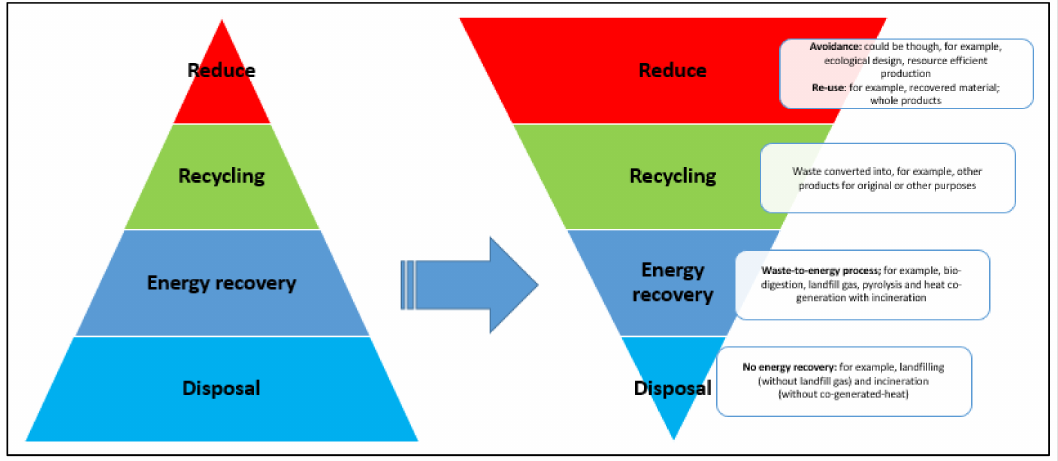
Figure 1. The waste management